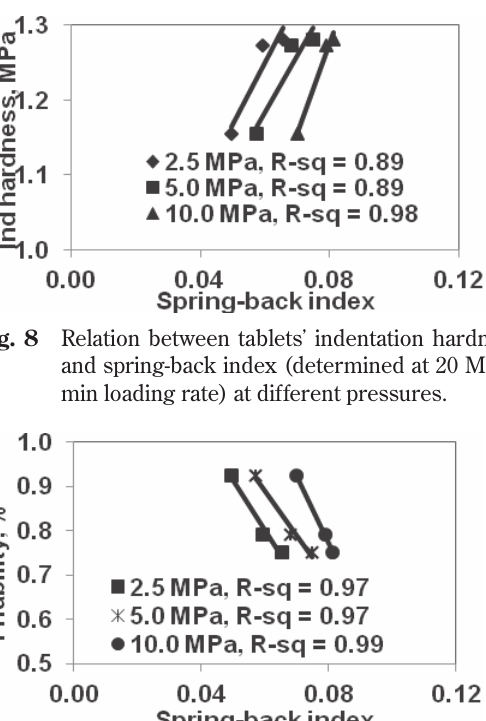
Fig. 7 Relation between tablets ʼ axial penetration strength and spring-back index (determined at 20 MPa/ min loading rate) at different pressures.